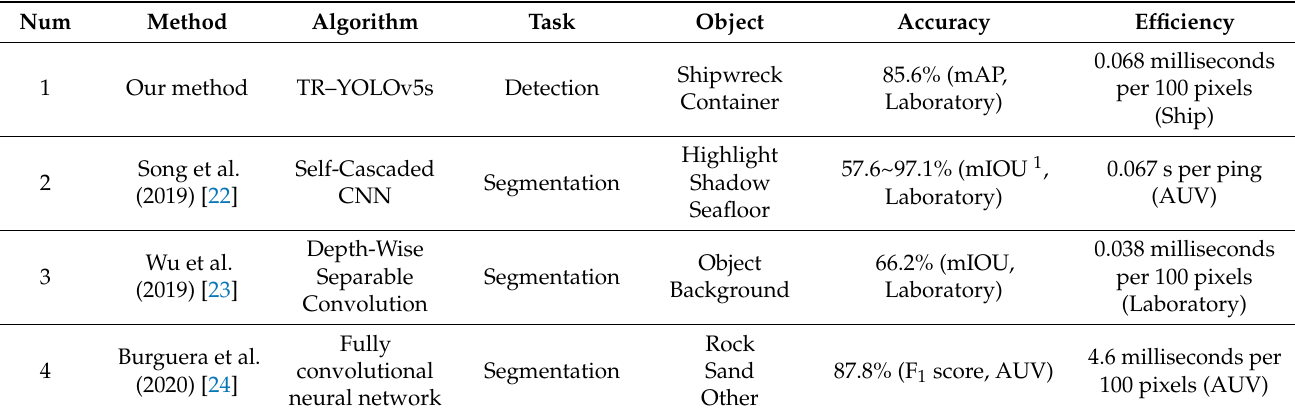
Comparison of our object detection method performance with existing real-time underwater object detection